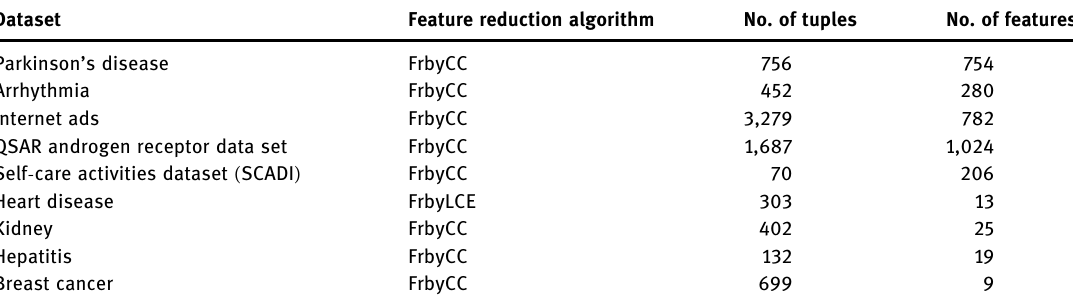
Table 2: Datasets under consideration Dataset